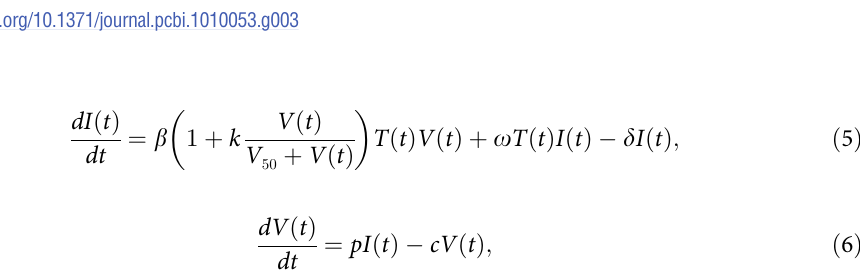
Fig 3. Promotion of cell-free HIV-1 infection by IFN- α under high cell-virus density. a A scheme of density dependence of the frequency of virus-cell contact. Nevertheless the numbers of cells and viruses are constant (cell number = 3, virus number = 9 in this panel), viruses and cells are condensed in smaller volume of culture (left panel; i.e., the value V/C is high), while viruses and cells are sparse in larger volume of culture (right panel; i.e., the value V/C is low). b-d Single-round infection assay under different density conditions. b The V/C value at five different culture conditions (0.5, 1, 2, 3, and 6 ml; corresponding to the experimental results shown in Figs 3C, 7C and S4 ) is shown. The V/C value is calculated as described in Methods. c,d Single round infection assay was performed using Jurkat- CCR5 cells ( c ) and primary human CD4 + T cells ( d , 2 donors) at five different cell-virus densities with or without IFN- α . Each color circle indicates the result from one culture, and three independent experiments were performed. The horizontal bars with error bars are the averages and SEMs of three ( c,d left ) or four ( d right ) independent experiments. Asterisks indicate statistically significant differences determined by Student’s t test ( p <